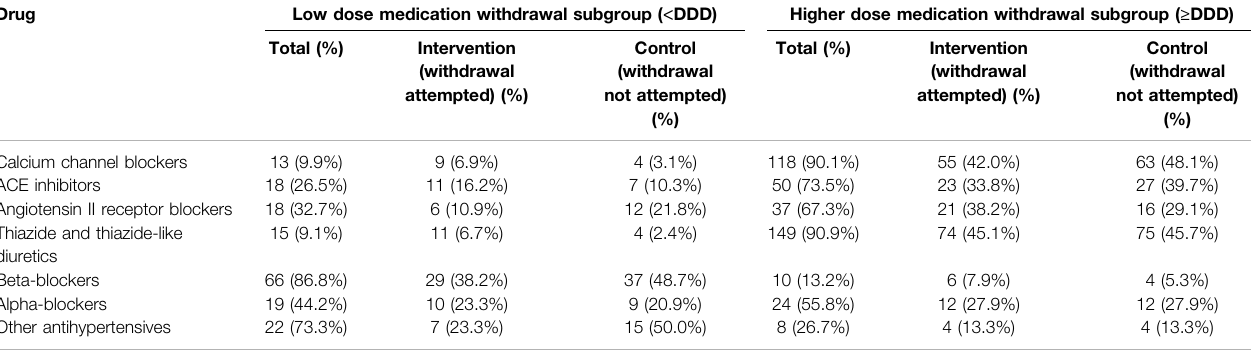
TABLE 3 | Antihypertensive medications chosen for withdrawal at baseline by drug class and medication